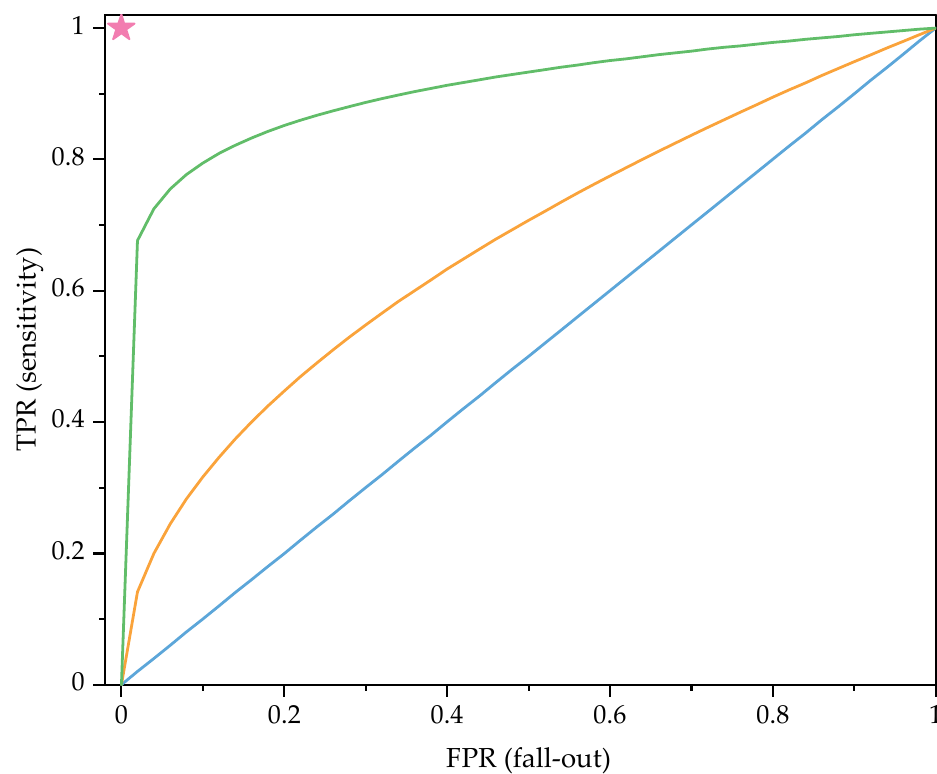
Figure 4. Example receiver operating characteristic (ROC) curves. The pink star indicates the ideal performance of a screening system whereas the green and orange lines represent successively worse performance. The blue line is the expected performance if the screening system randomly